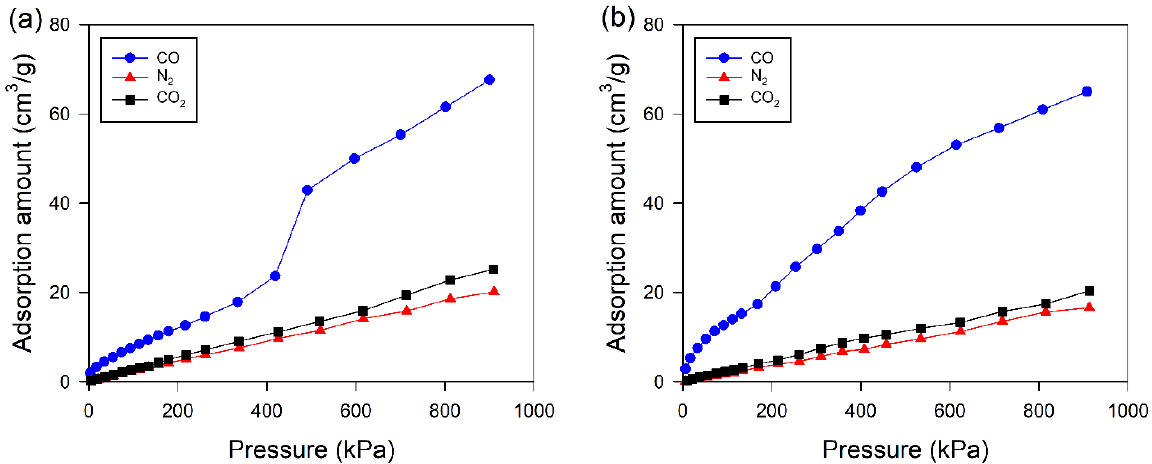
Figure 7. Comparison of adsorption isotherms of CO, CO 2 , and N 2 on ( a ) i-Cu(I)/ θ -Al 2 O 3 -500 adsorbent and ( b ) c-Cu(I)/ θ -Al 2 O 3 adsorbents.